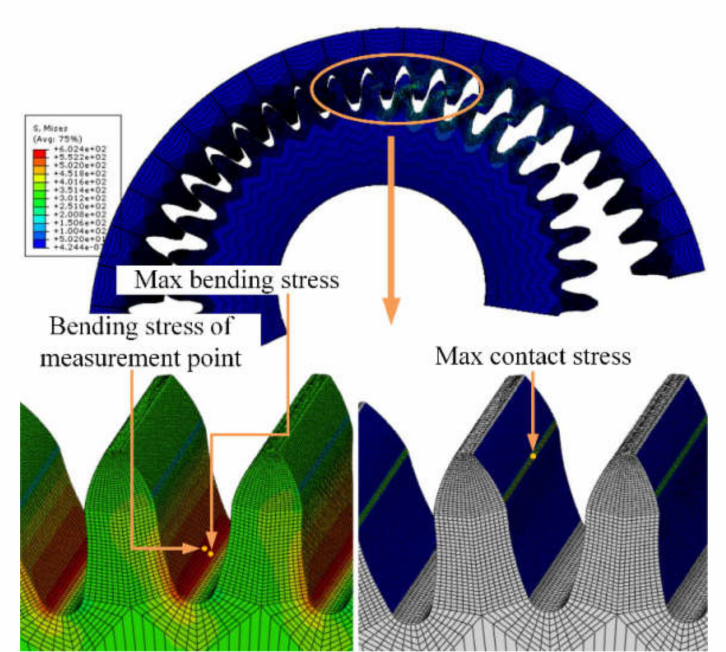
Figure 19. Bending and contact stress results of HCR internal spur gear pair at 540 r/min and 600 Nm.